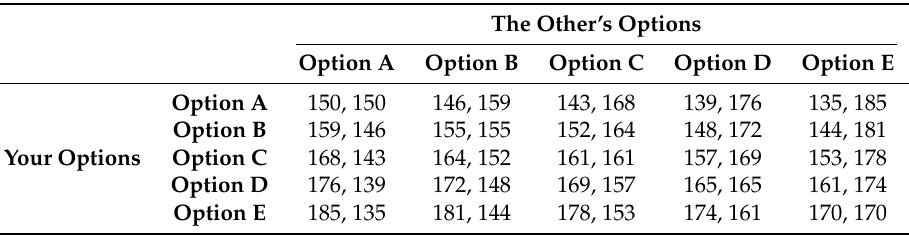
Table A4. Recomposition of task number three into a matrix